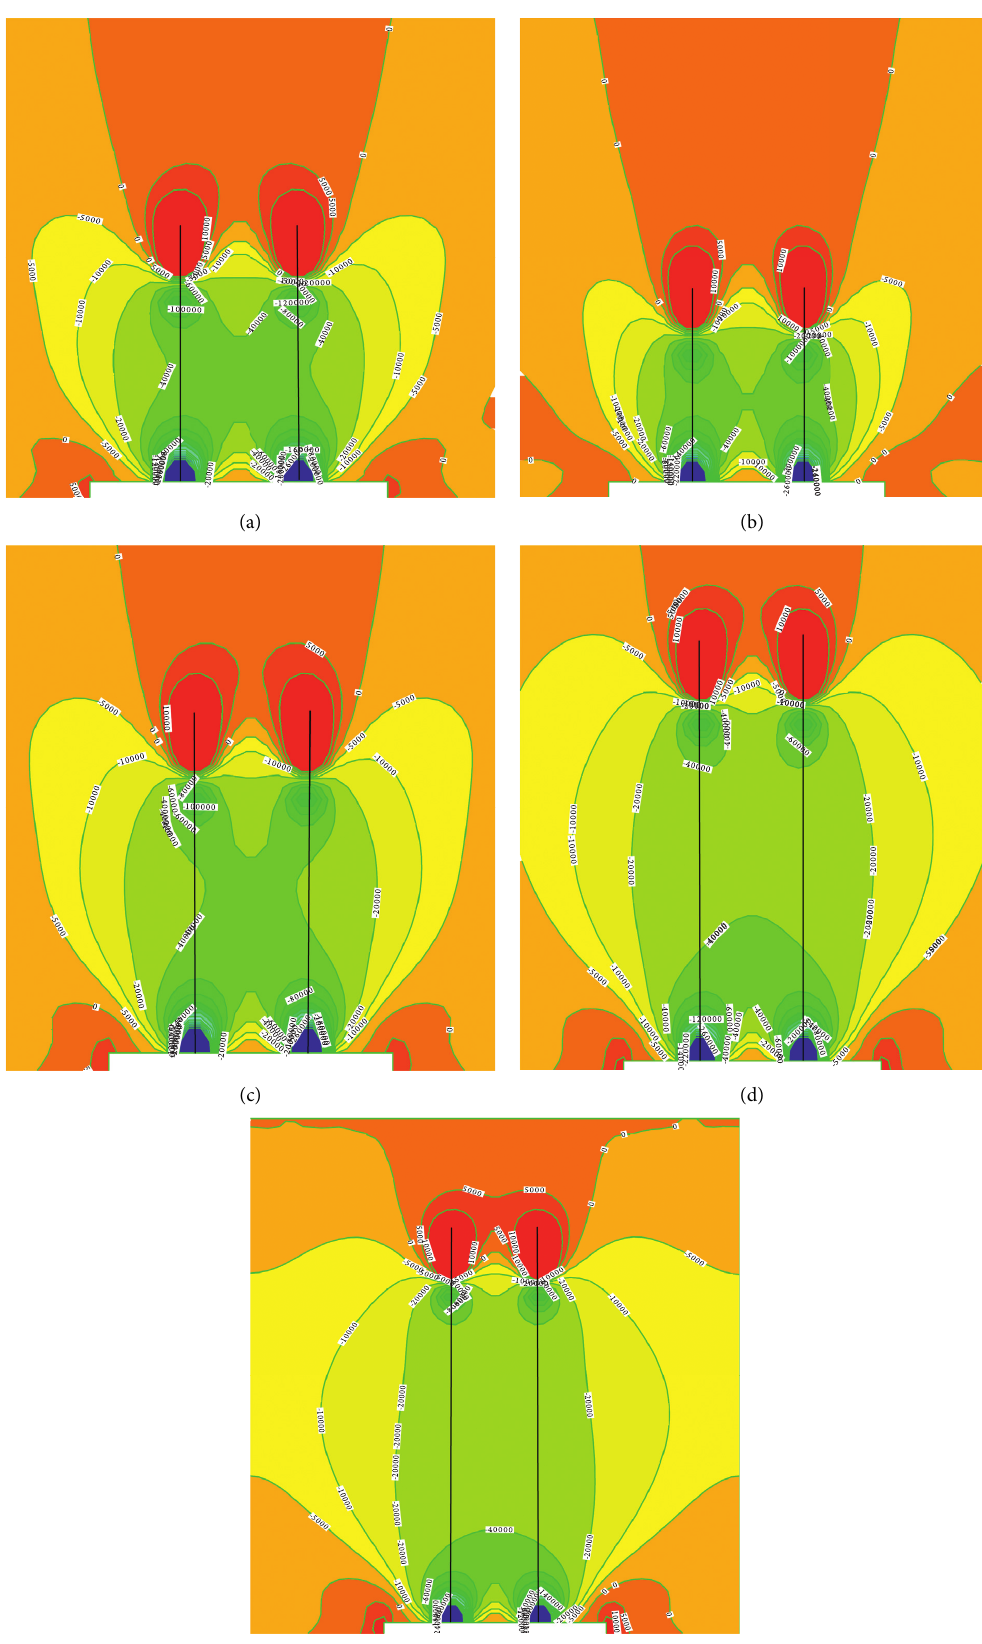
Figure 8: Stress distribution of different anchor cables lengths under the same prestress. (a) The length of anchor cables is 4m. (b) The length of anchor cables is 5m. (c) The length of anchor cables is 6m. (d) The length of anchor cables is 8m. (e) The length of anchor cables is